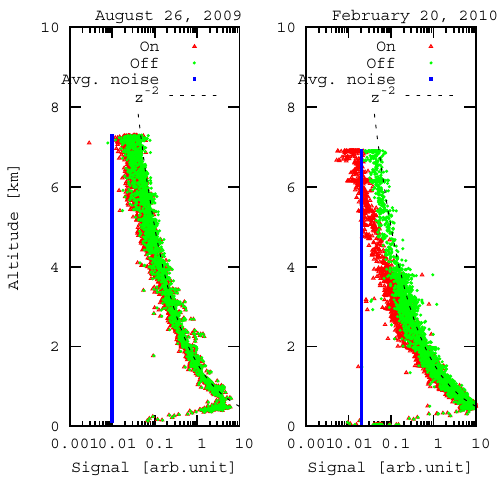
Fig. 4. Received return signals at various elevations in August 2009 (left panel) and February 2010 (right panel). Triangle ( 4 ): online signal; circle ( (cid:13) ): offline signal; square ( (cid:3) ): averaged noise level; dashed curve: z − 2 . The edge and center online wavelengths (Fig. 1) were used in August 2009 and February 2010, respectively.